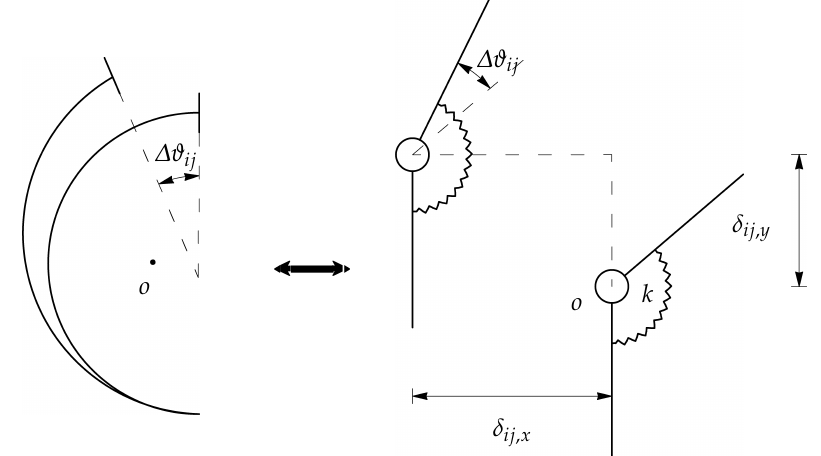
Figure 2. Rigid-body replacement and axis drift.